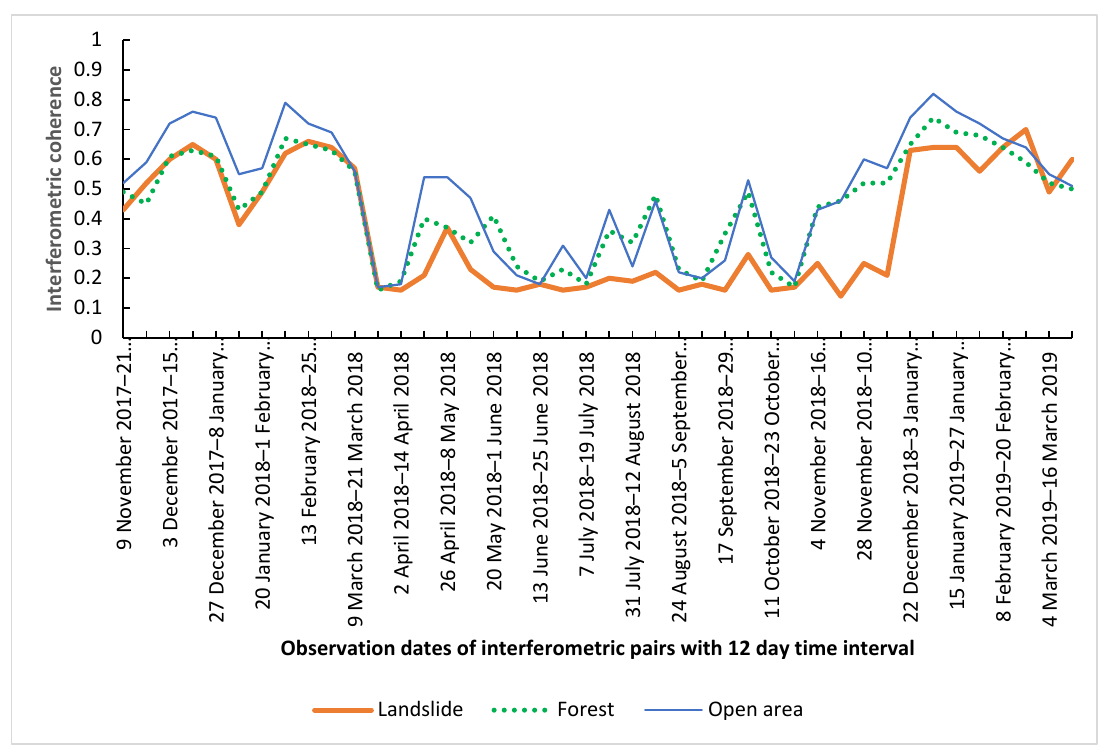
Figure 5. Temporal variation of coherence for three areas of interest: open area, forest, and landslide slope.